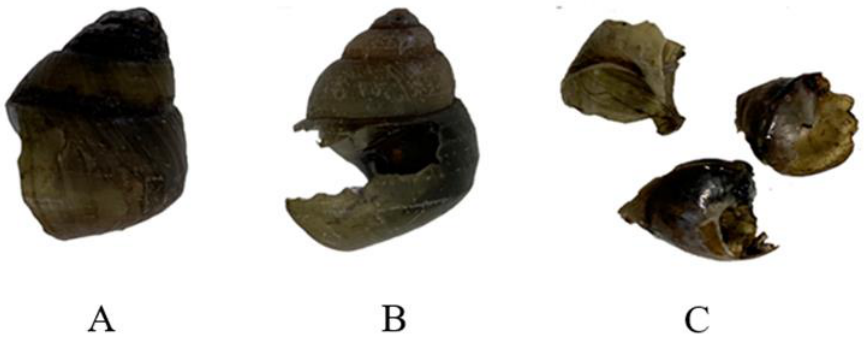
Figure 6. Illustration of shell conditions used to infer the handling method of E. sinensis : ( A ) probing, ( B ) peeling, and ( C ) crushing.